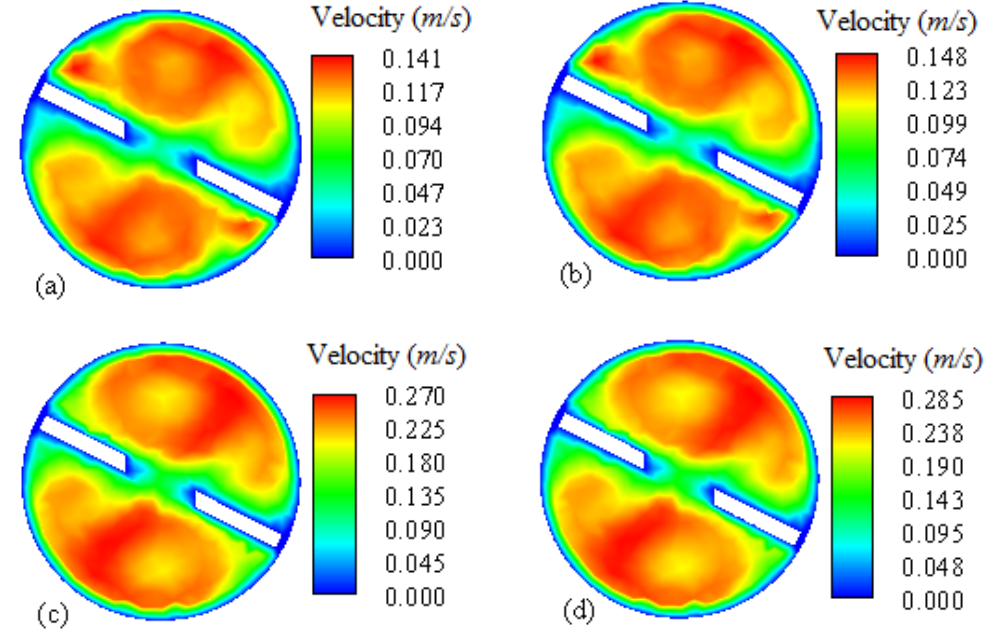
Figure 5. Velocity at axial location of 0.134 m before the flow end of the C-T tube’s cross-section for (a) 𝑹𝒆 = 𝟐, 𝟏𝟓𝟎 , (b) 𝑹𝒆 = 𝟐, 𝟑𝟎𝟎 , (c) 𝑹𝒆 = 𝟒, 𝟒𝟎𝟎 , and (d) 𝑹𝒆 = 𝟒,